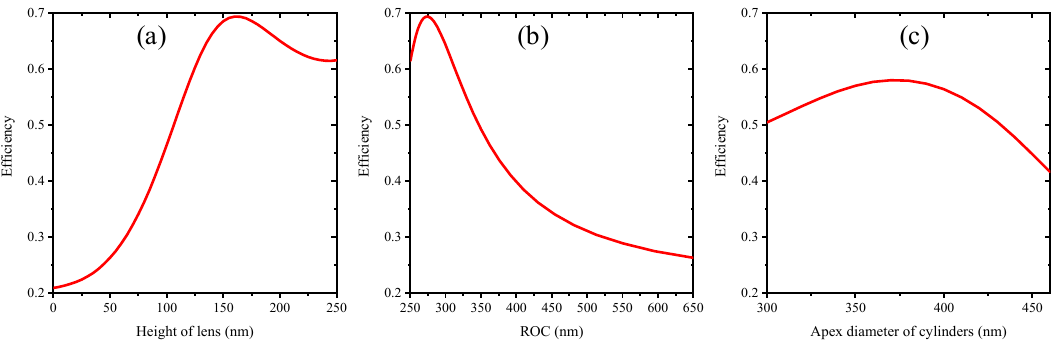
Figure 4. Photon collection efficiency of NV − center versus submicron structure dimensions. ( a ) efficiency versus lenses heights when diameters of lenses are 500 nm; ( b ) efficiency versus ROC of submicron lenses; ( c ) efficiency versus apex diameter of submicron cylinders.